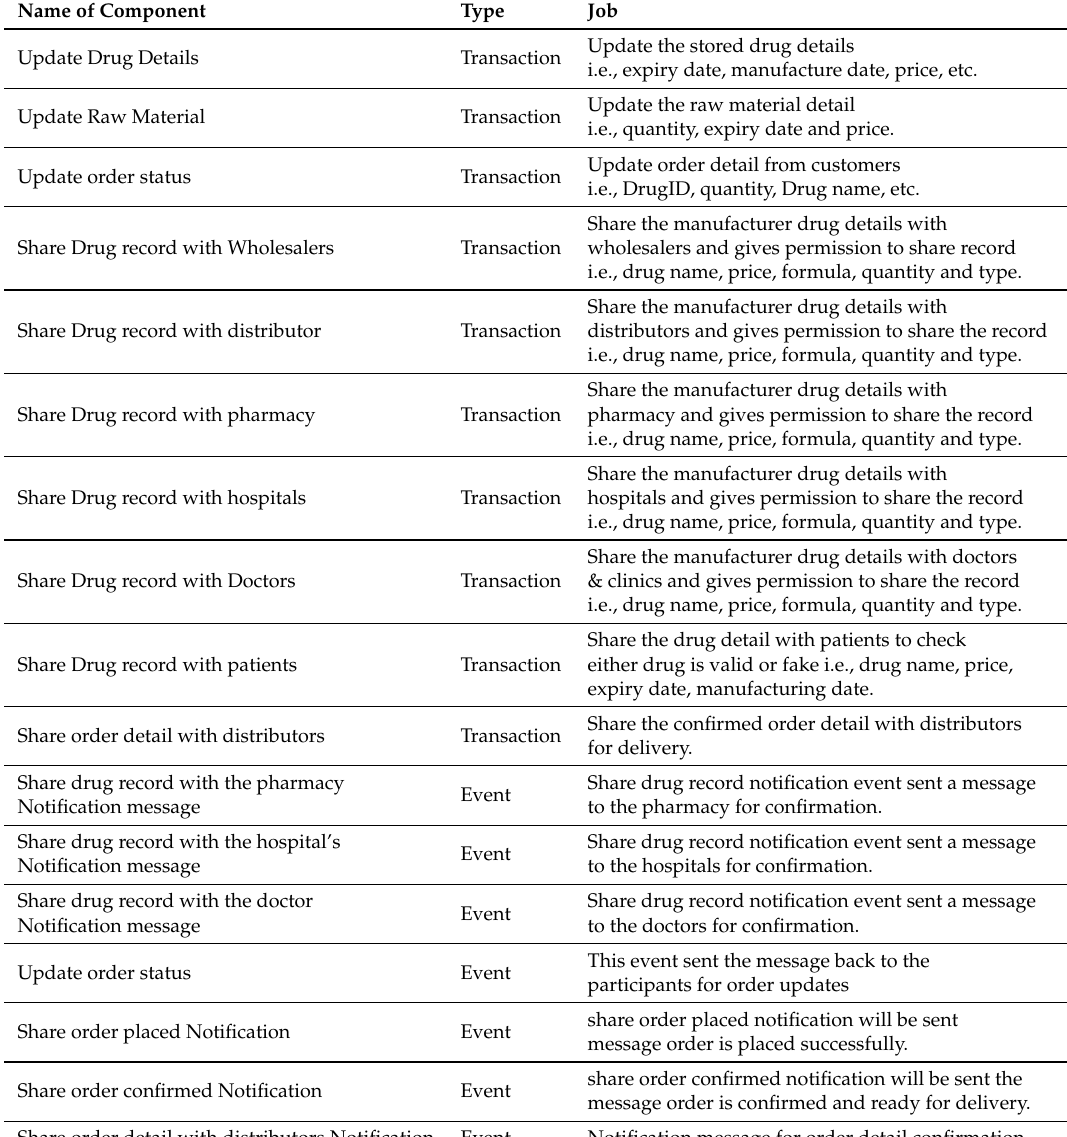
Table 3. Transaction and events definition in proposed